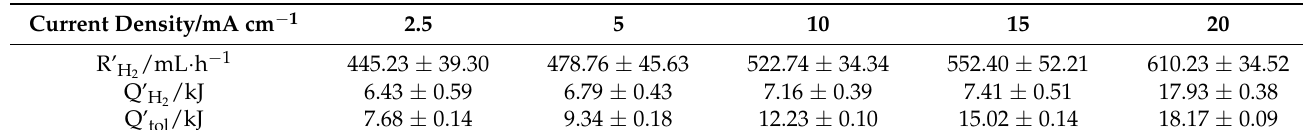
Figure 9. The proportion of Q Al , Q ORR , Q int , and Q H2 in Q tol under different discharge current densi- ties.